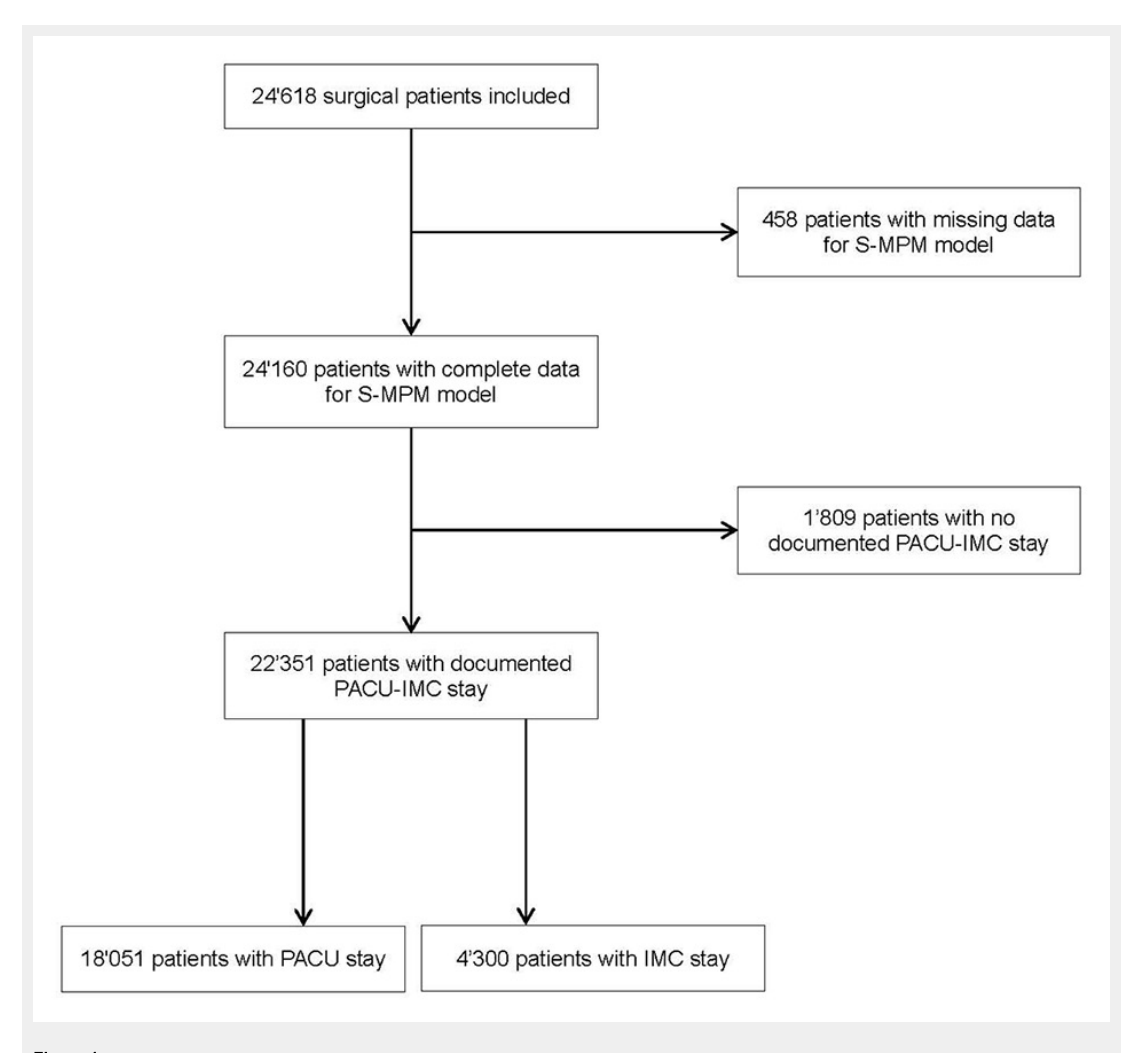
Flow chart of surgical patients included in the study. ICM = intermediate care unit; PACU = post anaesthesia care